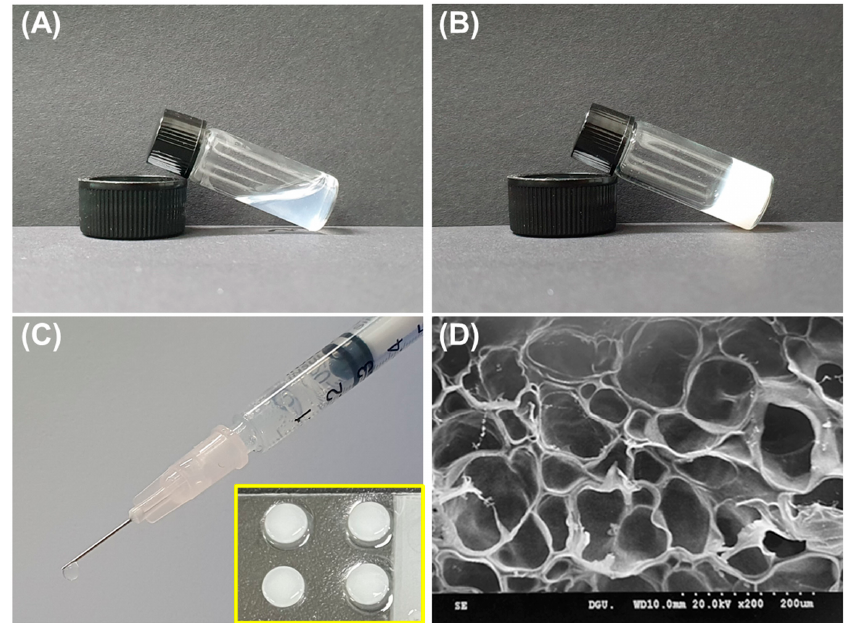
Figure 4. Characterization of 6MP-GPGel. ( A , B ) Sol–gel phase transition of hydrogels; ( C ) macro- scopic image of hydrogel injection using a syringe. Yellow box showing hydrogels fabricated using a Teflon mold; and ( D ) SEM image of cross-sectioned 6MP-GPGel.